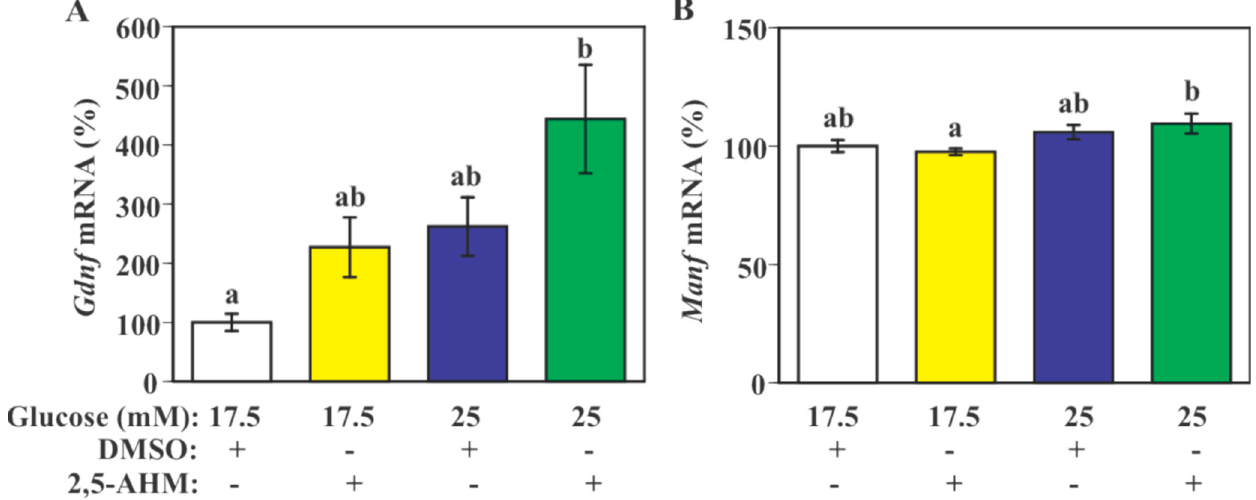
Figure 5. Effect of GLUT5 inhibition on glucose-induced Gdnf and Manf mRNA expression in microglial SIM-A9 cells. Cells were incubated in a culture medium containing 17.5 mM or 25 mM glucose in the presence of 2,5-AHM (2 mM) or DMSO (vehicle control) for 4 h. Levels of Gdnf ( A ) and Manf ( B ) mRNA were measured by real-time PCR. Values in the control group (17.5 mM glucose with DMSO) were set to 100%. Data are means ± S.E.M. ( n = 8–9/group). Groups that do not share a common letter are statistically different ( p < 0.05 by Tukey–Kramer test).